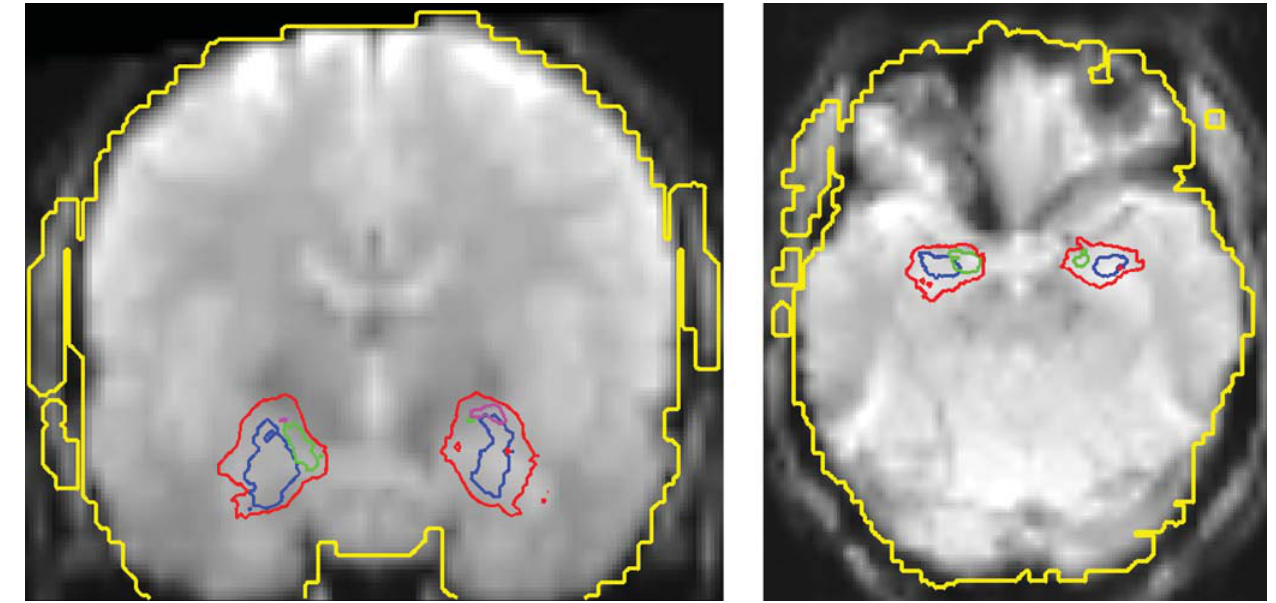
Figure 1. EPI data quality. A representative example of raw EPI (echoplanar imaging) data normalized to MNI space is shown in a coronar (MNI y= 2 7 mm) and axial (MNI z= 2 20 mm) section. The axial section corresponds approx. to the sections shown in [51]. The example represents the average across all EPI volumes acquired during the experimental session of one subject. The outline of the amygdala is shown (red line), enclosing the area with at least 50% probability of belonging to the amygdala (according to the probabilistic maps from [26]). The extent of the laterobasal (LB) group of the amygdala (LB, . =80% probability) is shown in blue, the superficial group (SF) in green, and the centromedial group (CM) in magenta. In addition, the outline of the segmentation mask enclosing the area with sufficient signal for application of point spread function (PSF) based EPI distortion correction (see reference [39] for further details) is shown in yellow. In all subjects, the whole analyzed extent of the amygdala was within the segmentation mask and therefore distortion correction was possible in this region. Good EPI signal quality in the amygdala region was achieved in all subjects investigated.